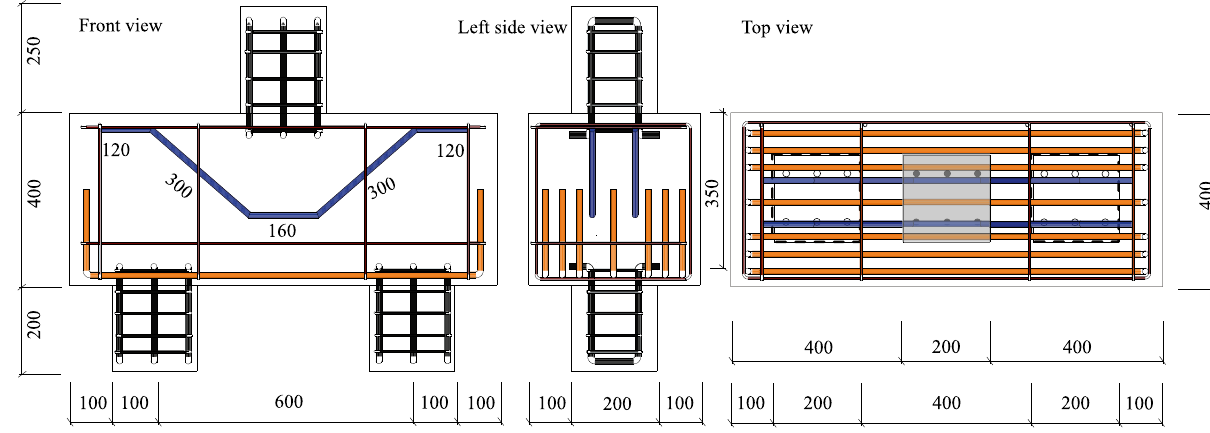
Figure 4. Pile cap dimensions (in mm).